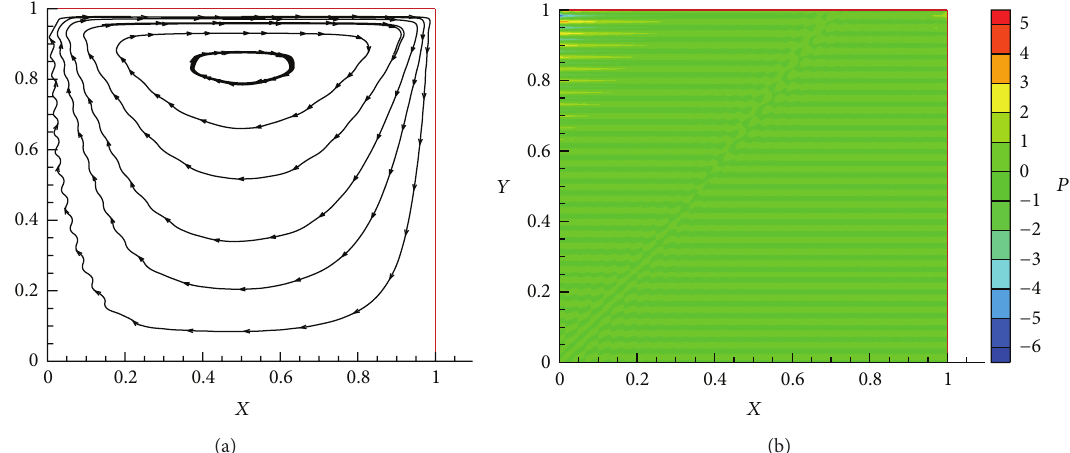
Figure 3: Velocity streamlines (a) and pressure level lines (b) for the multiscale enrichment method with 𝜀 = 1.0𝑒 − 6 , 𝛼 = 100 , and 𝑟 = 4 ,